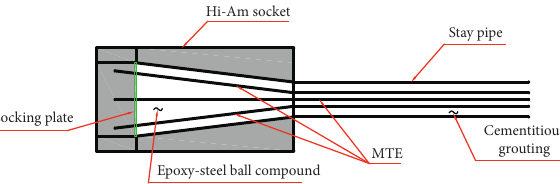
Figure 3: Schematic of Hi-Am socket used in Yonghe